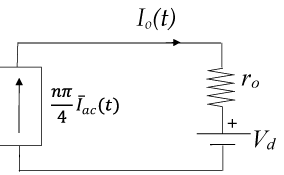
Figure 9. DC output current obtained from the envelope of the AC side output current.